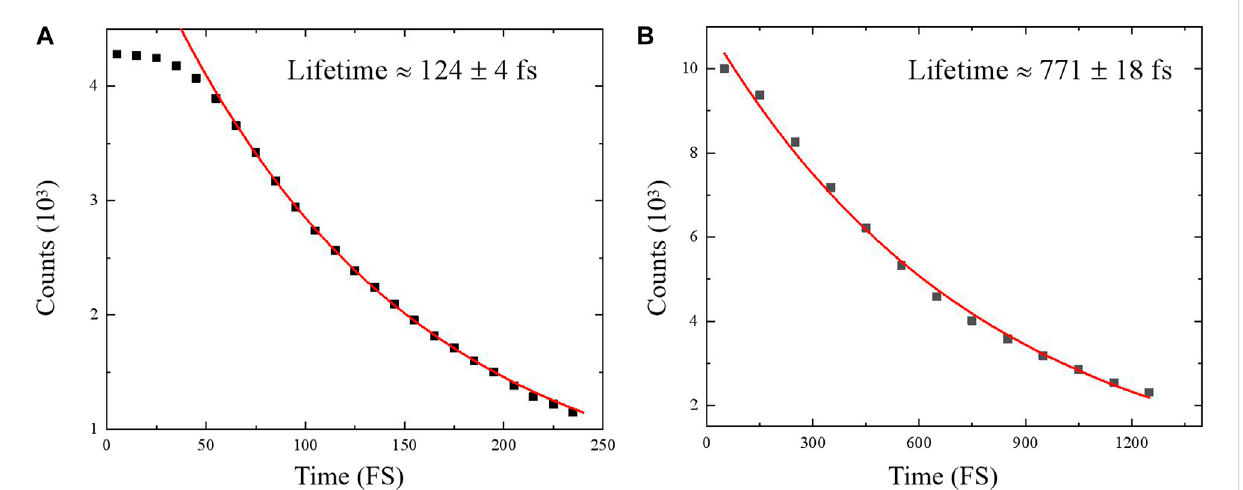
FIGURE 1 Numberof undissociated trajectories versus simulationtime of state ~ D 1 A ′ (panel (A) )and ~ F 1 A ′ (panel (B) ). Thelifetimesareobtained through a fi tting procedure with an exponential function. Points arethe simulated values and lines arethe fi ttedcurves. The uncertaintiesare due to the fi tting procedure.